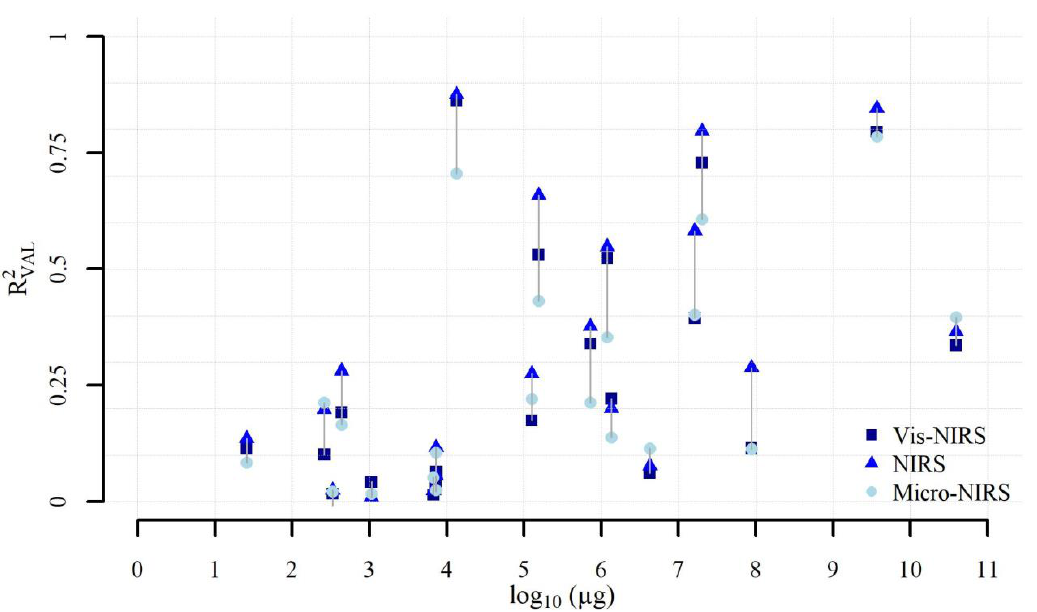
Figure 4. Relationships between the mean concentrations of the minerals in meat and the accuracy ( R 2 VAL ) of their predictions obtained from the three NIR spectrometers.